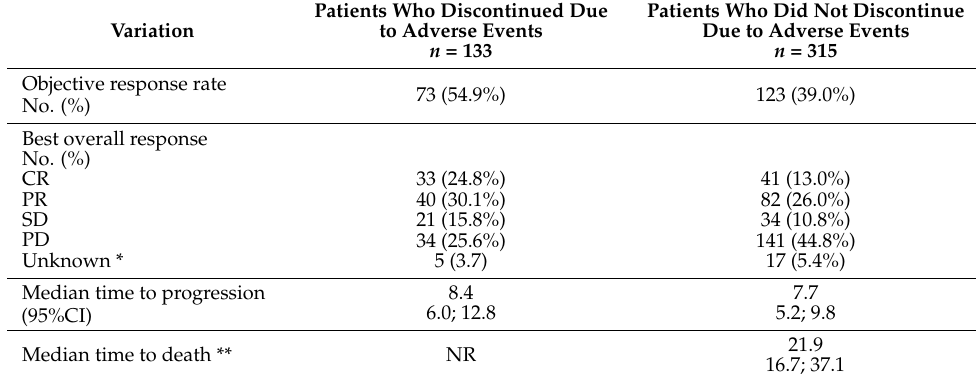
Table 2. Response to